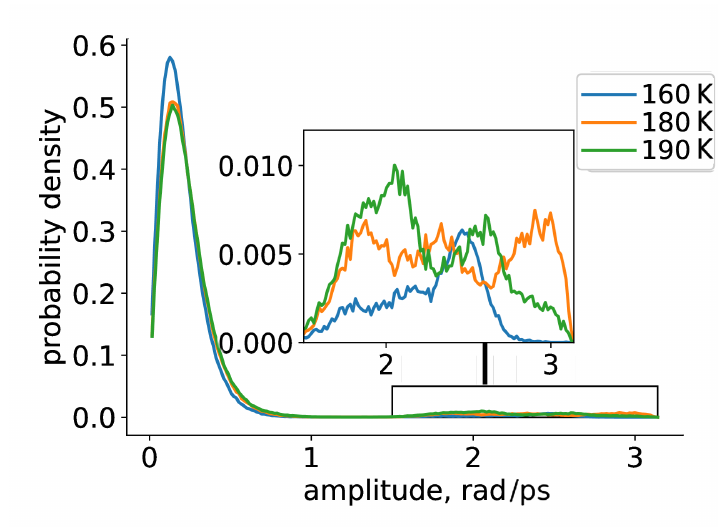
Figure 3. Rotational spectra of TEMPO radical at different temperatures.